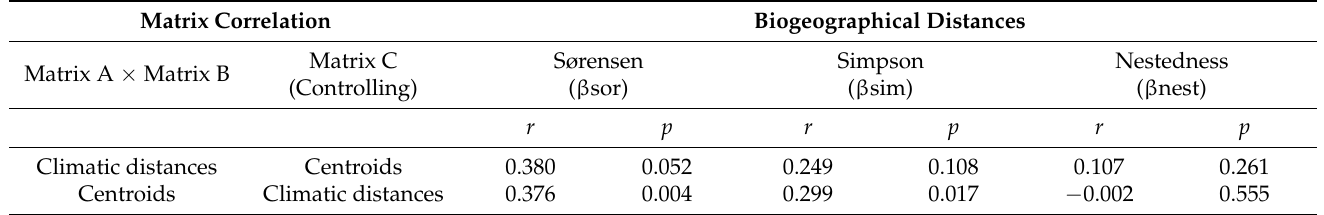
Table 2. Partial Mantel tests of biogeographical distances against climatic and geographical distances for Italian